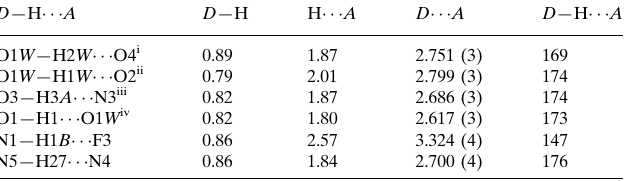
The hexafluoridophosphate anion is disordered over two positions with site-occupancy factors of ca 0.6 and 0.4.